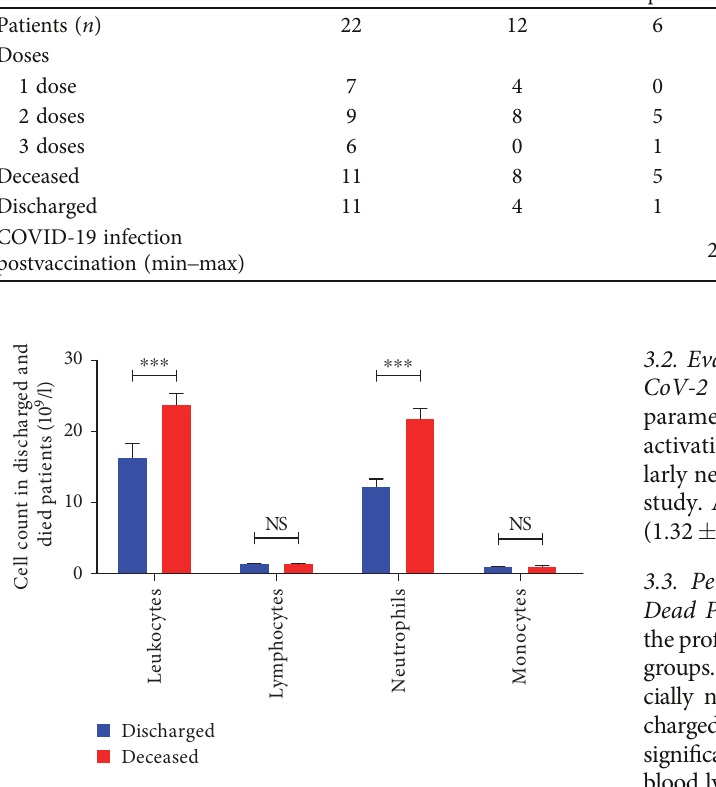
F IGURE 2: Immune cell count in peripheral blood of all deceased ( n =59) and discharged ( n =35) patients. Each histogram represents the studied population. Blue boxes correspond to discharged patients and red boxes represent deceased patients. NS, no signi fi - cant; ∗∗∗ p < 0 :